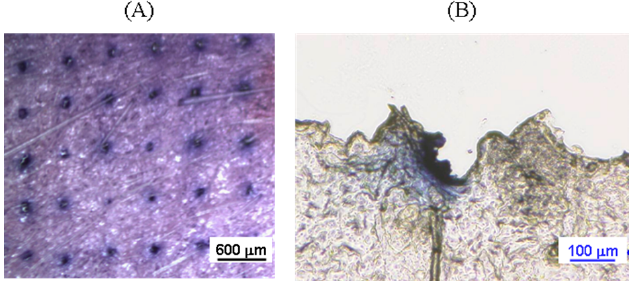
Figure 4. Photograph ( A ) and micrograph ( B ) of rat skin after application of ALN(TIP)–MN. Scale bar: ( A ) 600 µm, ( B ) 100 µm.